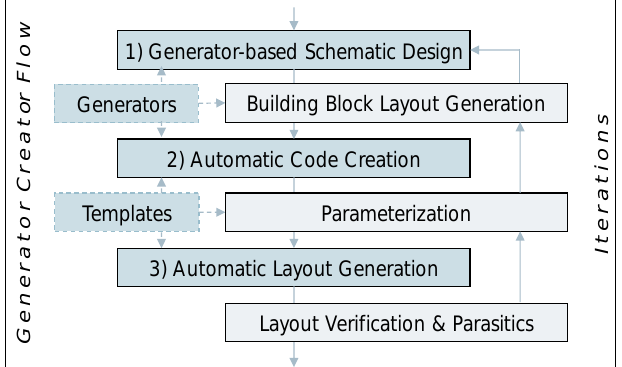
Figure 9. Depiction of the Generator Creator flow. The basic steps include generator-based schematic entry, automatic code creation, and automatic layout generation. During these steps, both already existing procedural building block generators and flexible templates are utilized. Based on the generated results, iterations might be required in order to adapt (sub) generator parameters.